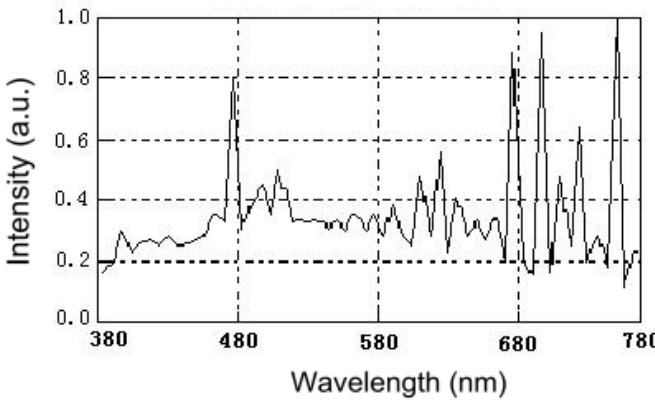
Figure 10. The irradiance spectrum of the Xeon lamp light (cited from [45]).